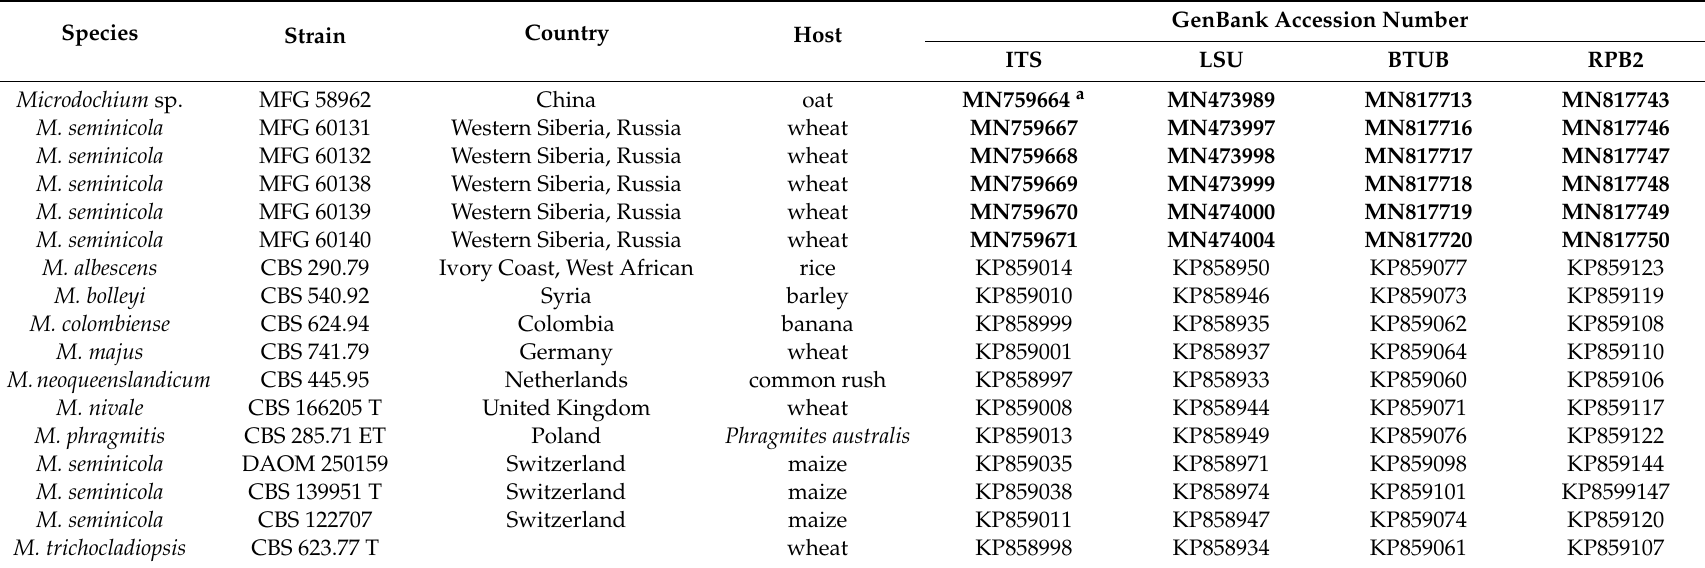
a Bold indicates the numbers of sequences obtained in this